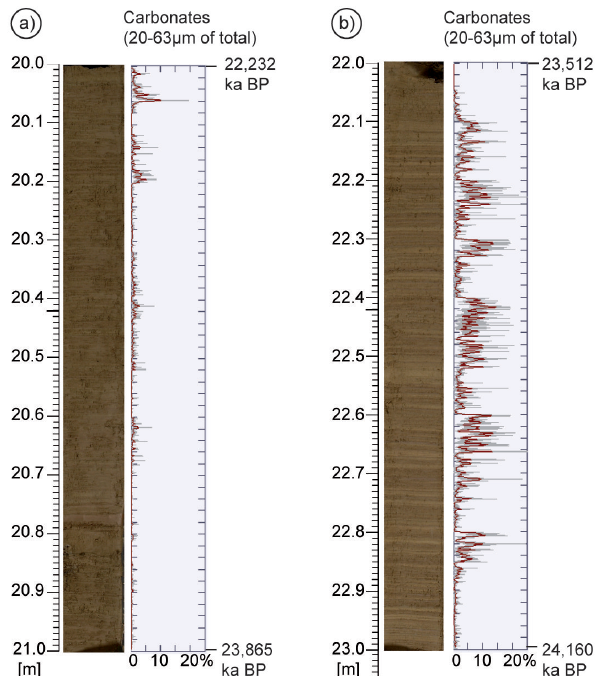
Fig. 6. The comparison of two sediment core sequences. De3 21–20m (22865–22232yearsBP) and De3 23–22m (24160– 23512yearsBP) shows the variation of sediment structures for the periods of (a) the interstadial GIS-2 and (b) the previous Heinrich- 2. It is obvious, that the core sequence 23–22m is characterized by coarse lamination in consequence of variable sediment composi- tion. This alternation of carbonate rich and carbonate poor sections is caused by often changing wind